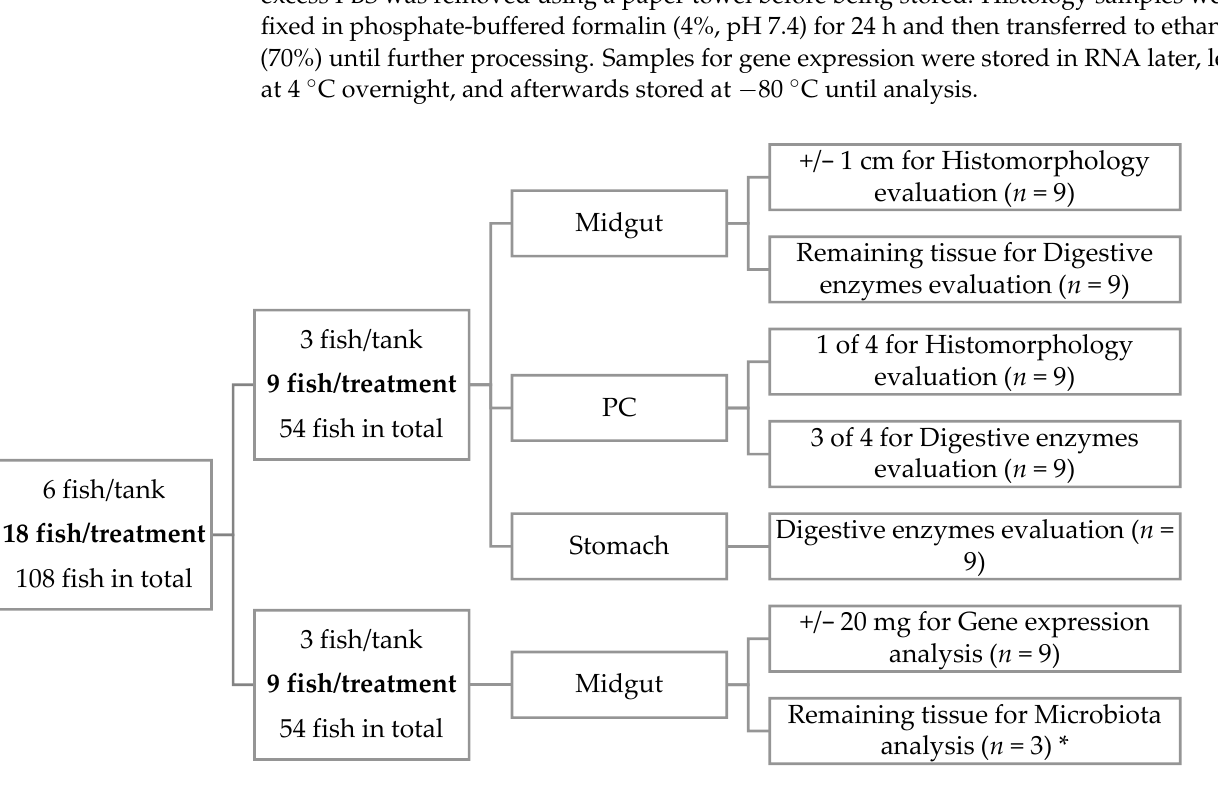
Figure 1. Schematic representation of sampling methodology applied in the present work. * In microbiota, only 2 of 3 fish per tank were used, and the samples were pooled to reduce individual variation, accounting for n = 3 per treatment.